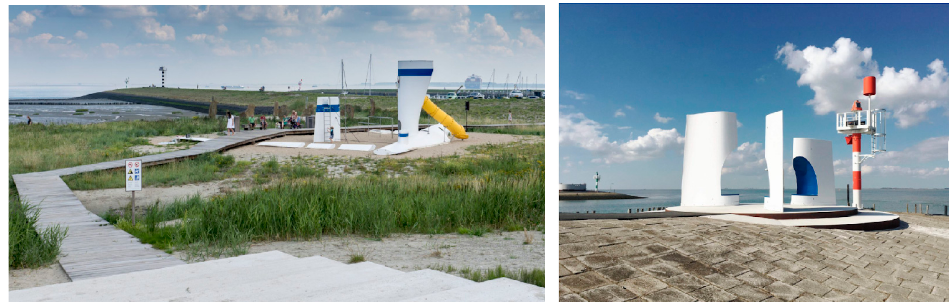
Figure A8. A blade-made playground and seating furniture in Terneuzen [48].